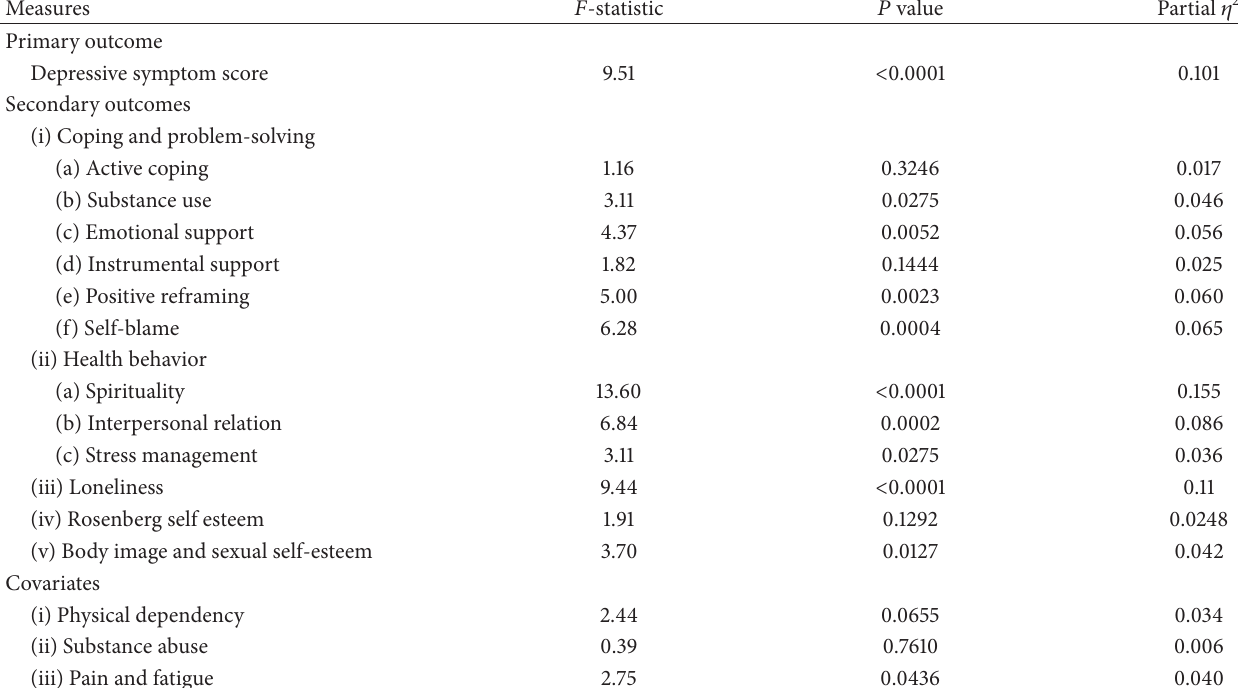
Table 3: Statistical inference on the interaction effect between time and treatment. The analyses are based on the data for the first four time points. That is, intervention group completed the study, and wait-list group completed the control period time of the study. Measures 𝐹 -statistic 𝑃